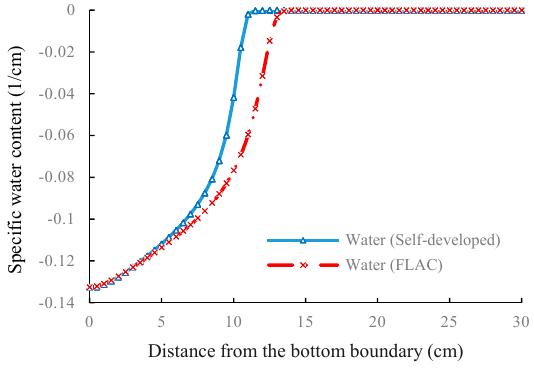
Figure 8. Simulated specific volumetric water content distribution after 5000 s.